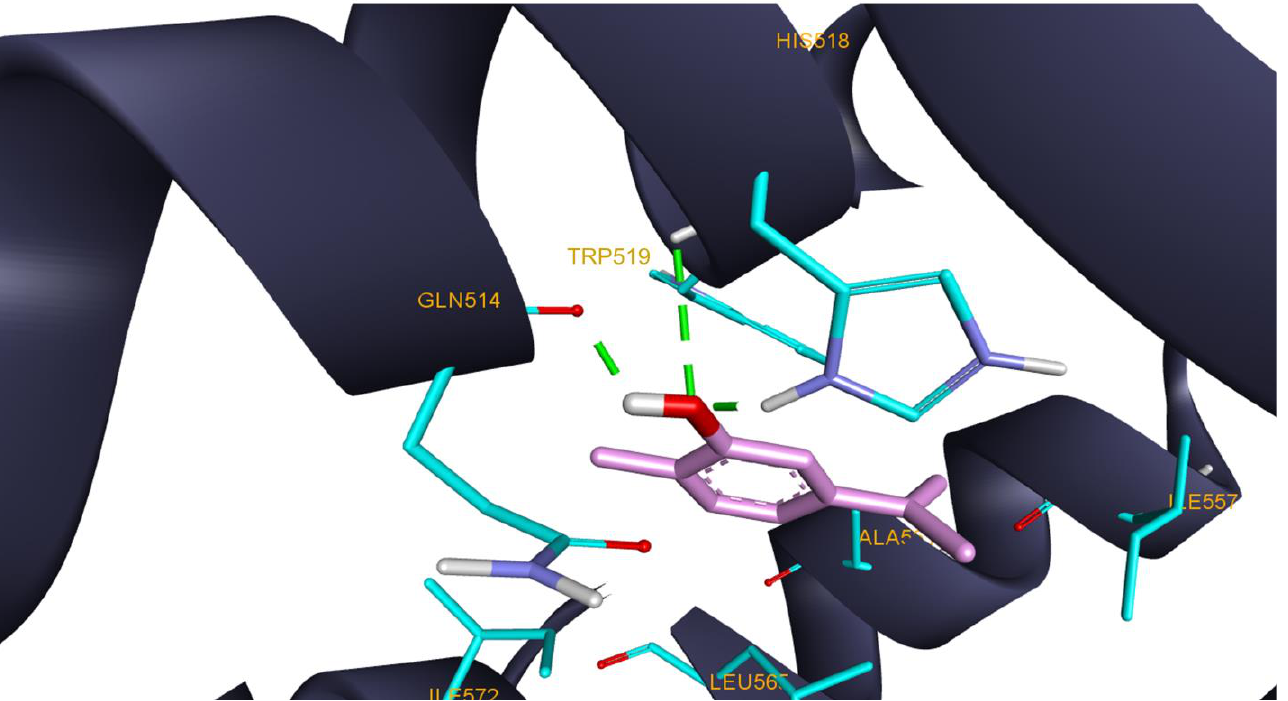
Figure 5. Structure of lipoxygenase (1N8Q) in complex with docked compound 26 (carvacrol) interacting with highlighted amino acids (cyan) Gln514, His518, and Trp519 through HB; hydrophobic interactions are omitted for better picture quality.